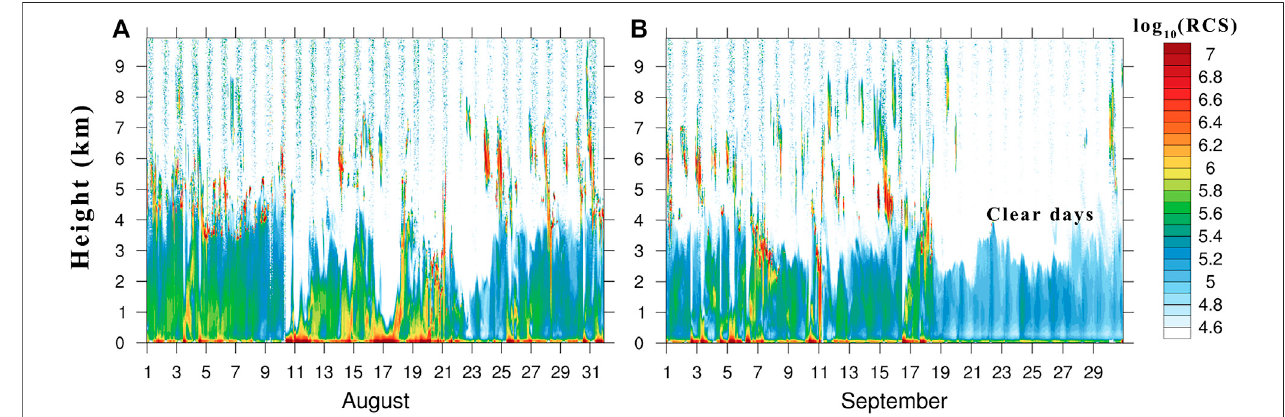
FIGURE7| Timeseriesof30-minaveragedlog 10 (RCS)oftheceilometeraftersmoothingsignalsatTazhong. (A) August. (B) September.Thereare12consecutive clear-sky days since September 19, 2019.